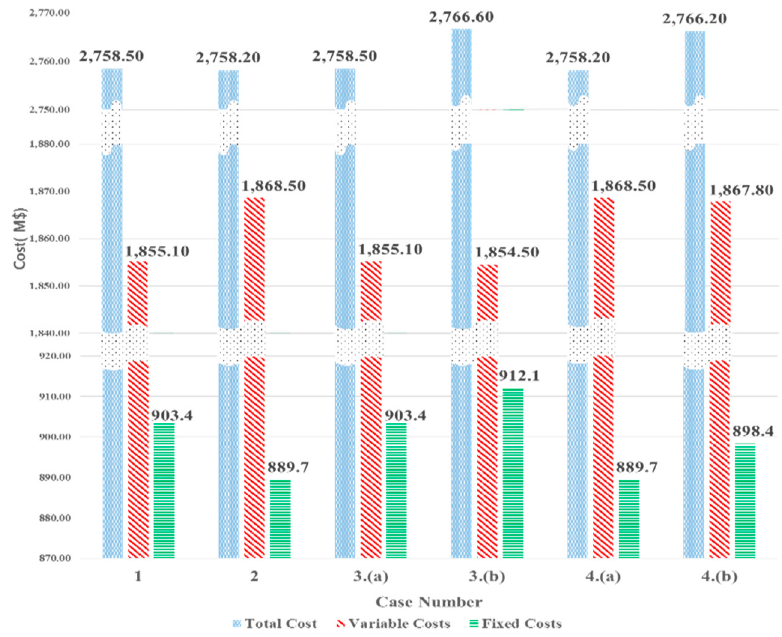
Figure 10. Estimated costs by case. (Note that, in the Case 3 and 4, (a) means a case with forced allocation of RES and (b) means a case without forced allocation of RES).